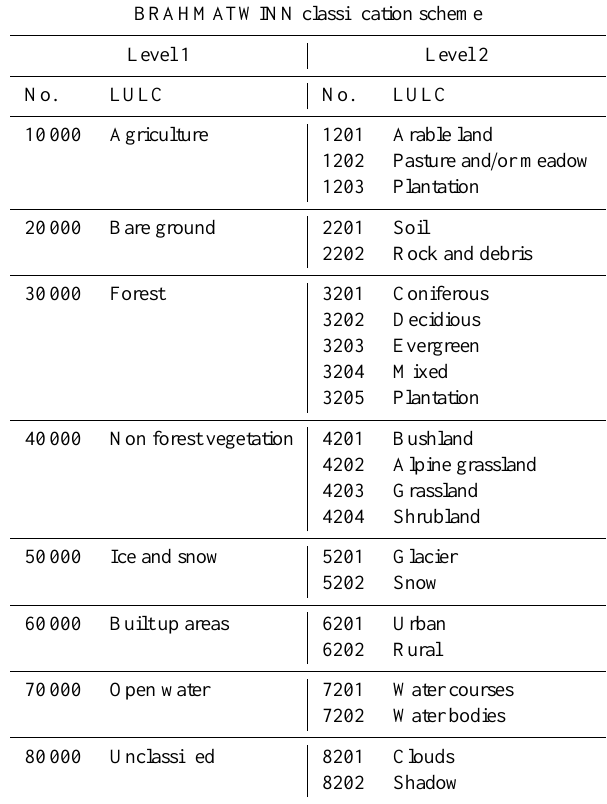
Table 3. Classification scheme with subclasses for level 1 and level 2.